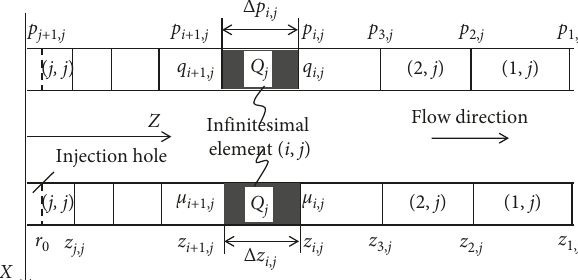
Figure 4: Infinitesimal elements of the concentric cylindrical annulus of the grouted zone with time step Δ t